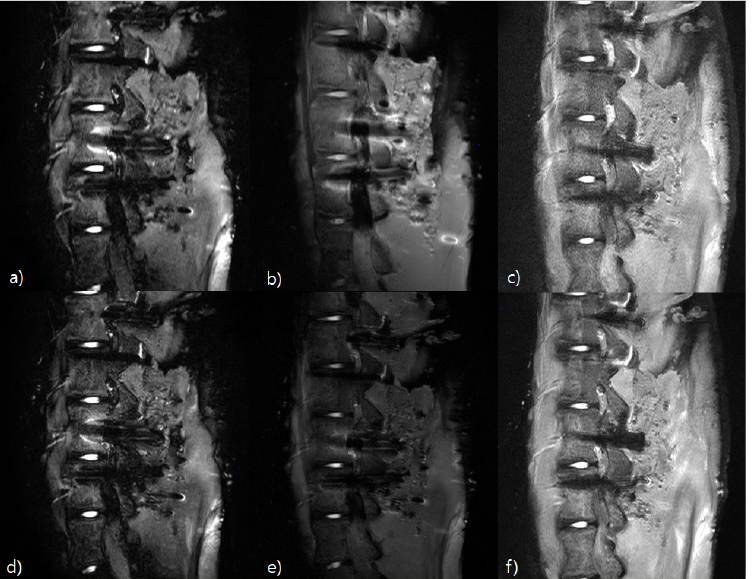
Figure 6. Evaluation of T1, T2 image qualities using Pig L-Spine Phantom. Visually, compared to the other two techniques, T1, T2 SEMAC (SPIR) has a brighter signal intensity and higher MAR effect. T1 STIR Image ( a ); T1 mDixon Image ( b ); T1 CS-SEMAC Image ( c ); T2 STIR Image ( d ); T2 mDixon Image ( e ); and T2 CS-SEMAC Image ( f ).